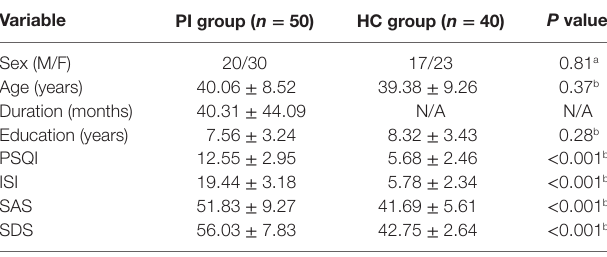
Table 1 | Demographic, sleep, and emotional scales of all participants.